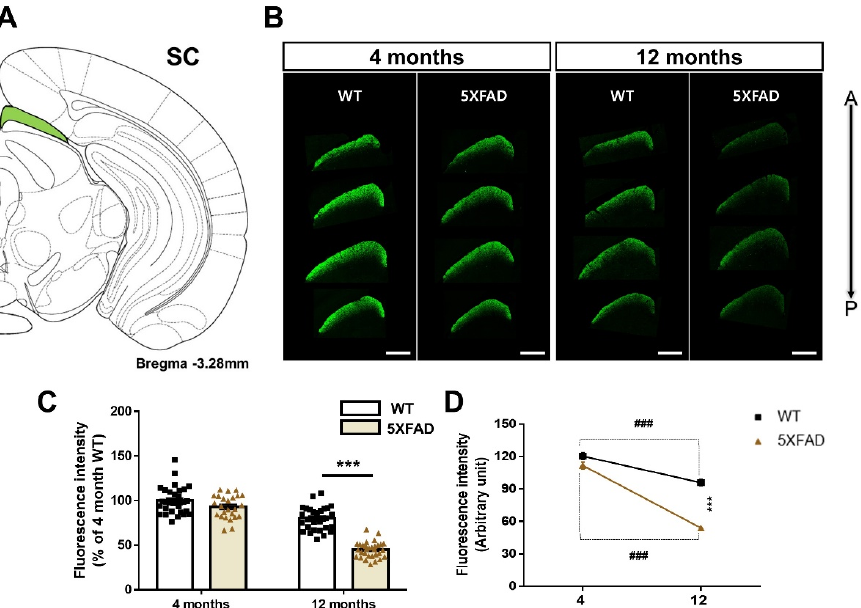
Figure 6. Degeneration of the retina-superior colliculus (SC) pathways in WT and 5XFAD mice. ( A ) Image of a mouse brain atlas illustrating the location of the SC. ( B ) The representative images indicate CT β transported from the retina to the SC. Scale bar = 500 μ m. ( C ) The quantitative graphs exhibit the fluorescence intensity of CT β (+) areas in the SC of WT and 5XFAD mice (25 − 32 images of the brain sections were obtained from 5 mice in each group). ( D ) Comparison of the impairment of the retina-SC connection by aging and AD progression. Statistical analysis was conducted by two-way ANOVA, followed by Tukey’s post hoc test. *** p < 0.001 and ### p < 0.001 indicate a significant difference.